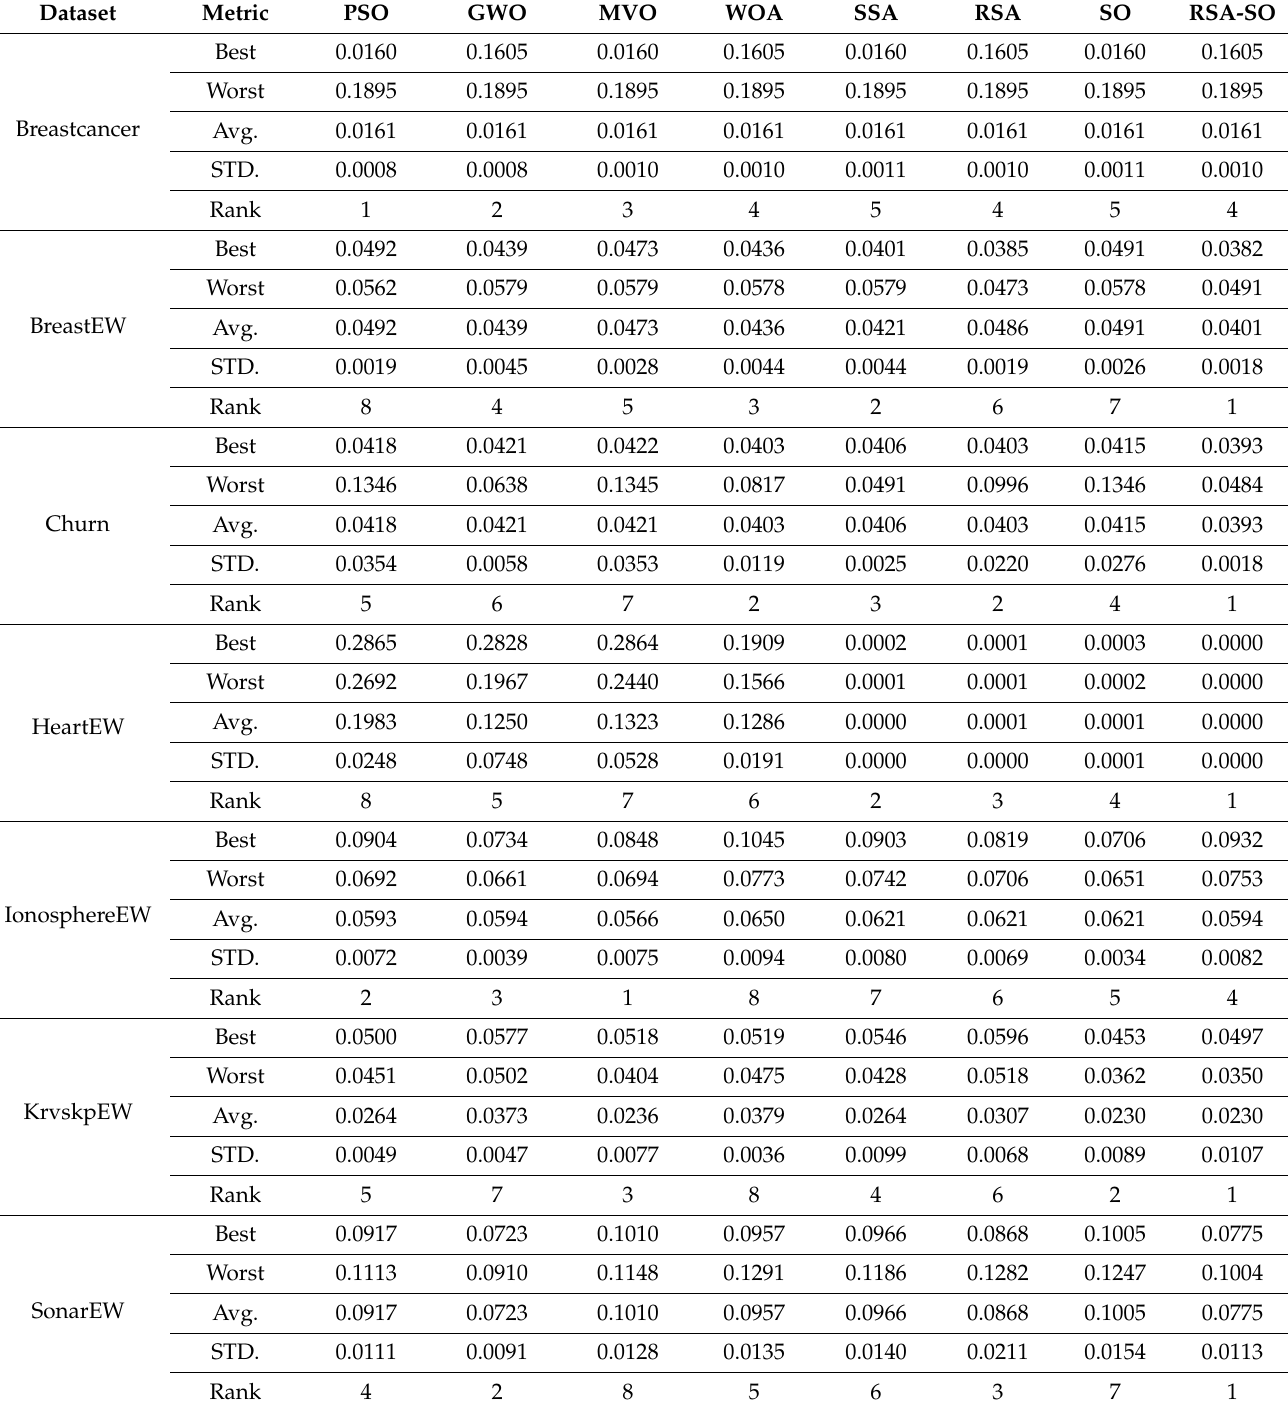
Table 5. Best, worst, Avg, and STD fitness values obtained by different